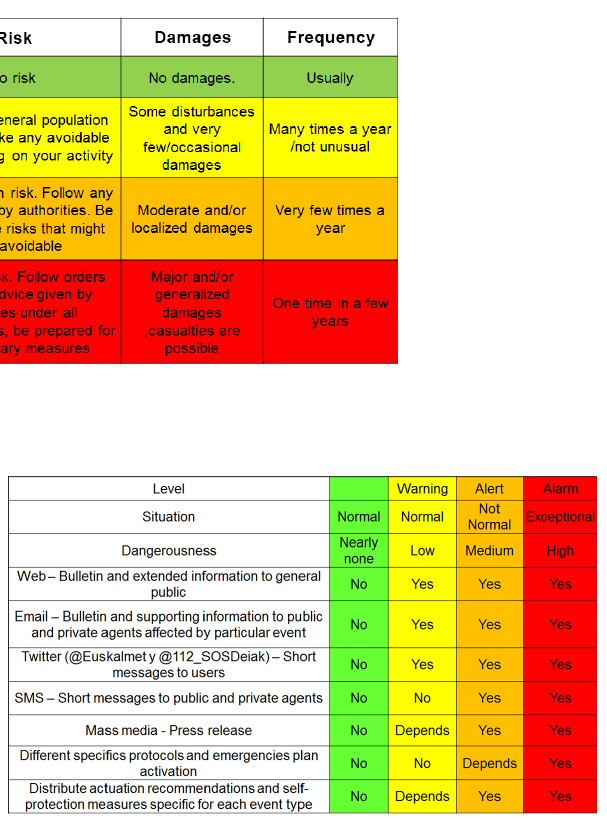
Figure 2. Operational procedures for severe weather